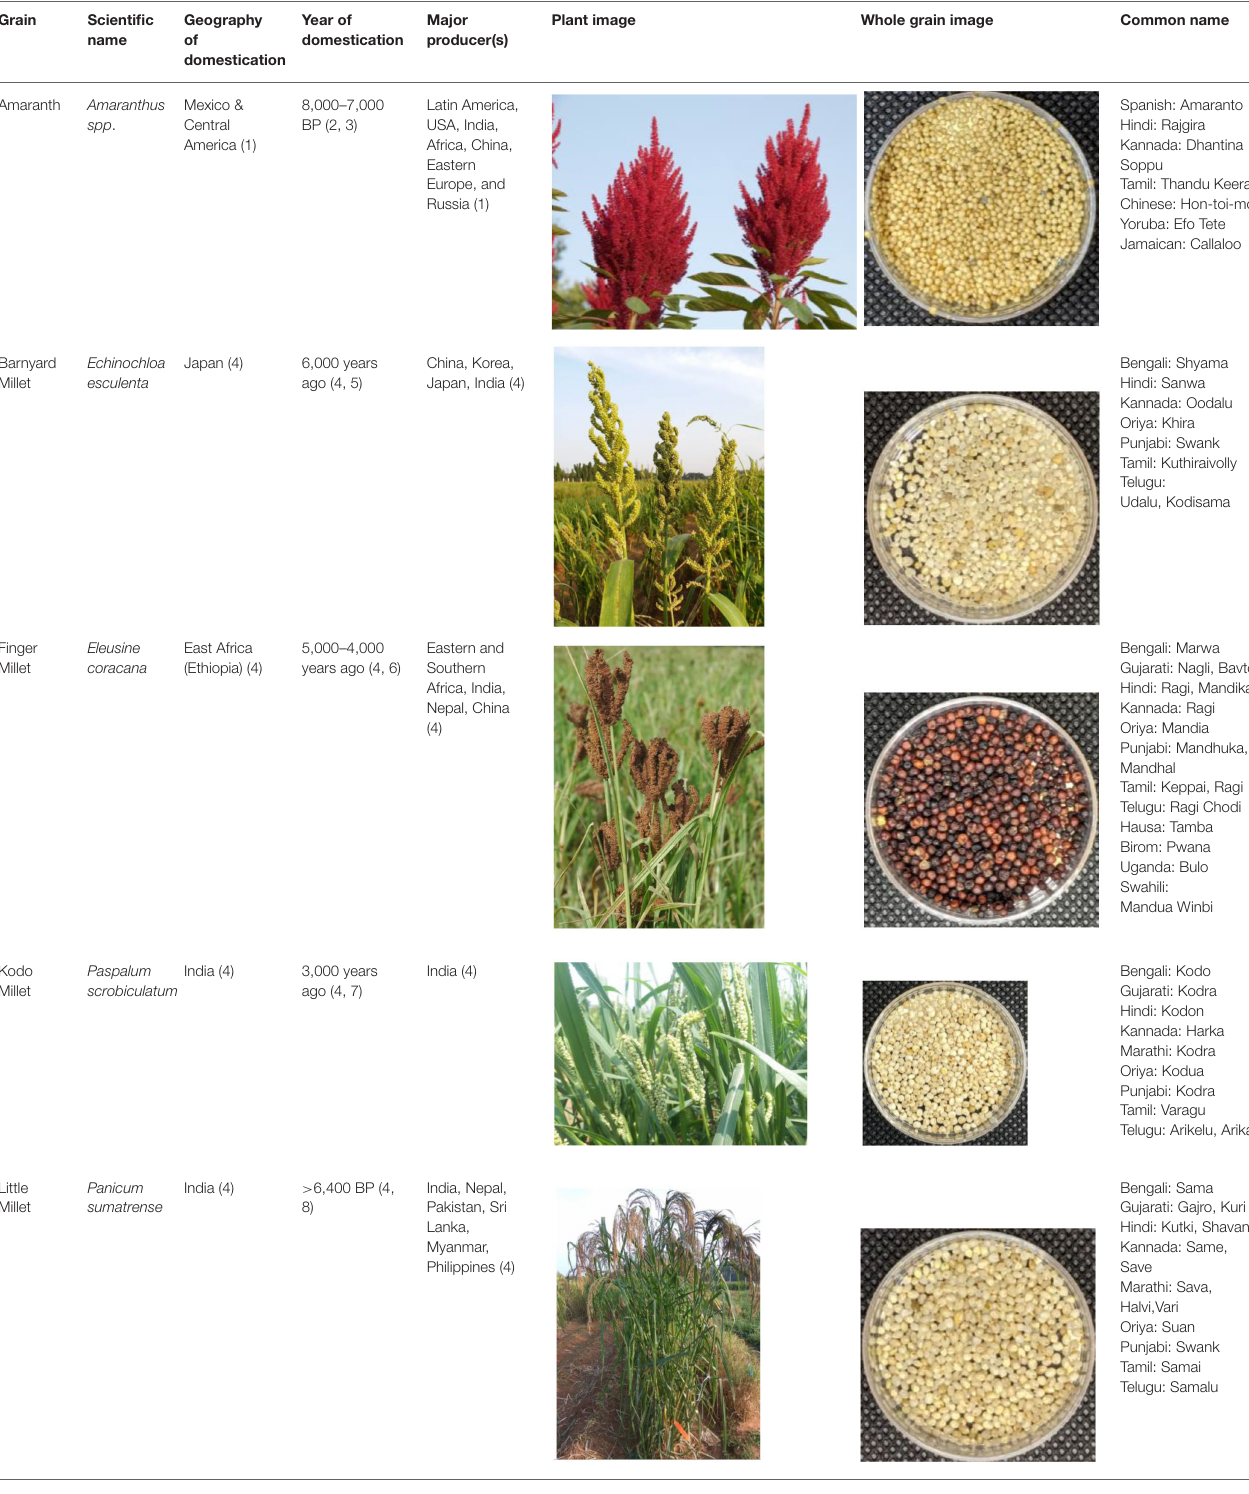
Amaranth Amaranthus spp .